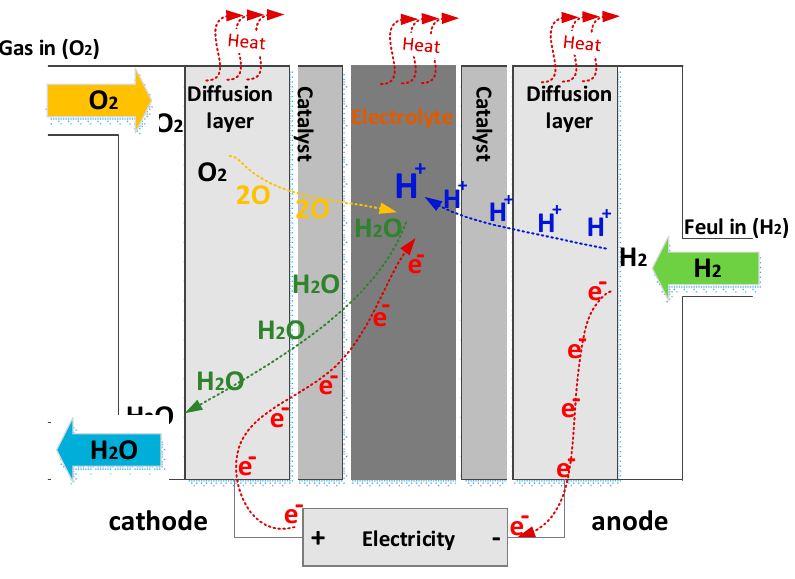
Figure 3. Structure of PEMFC.